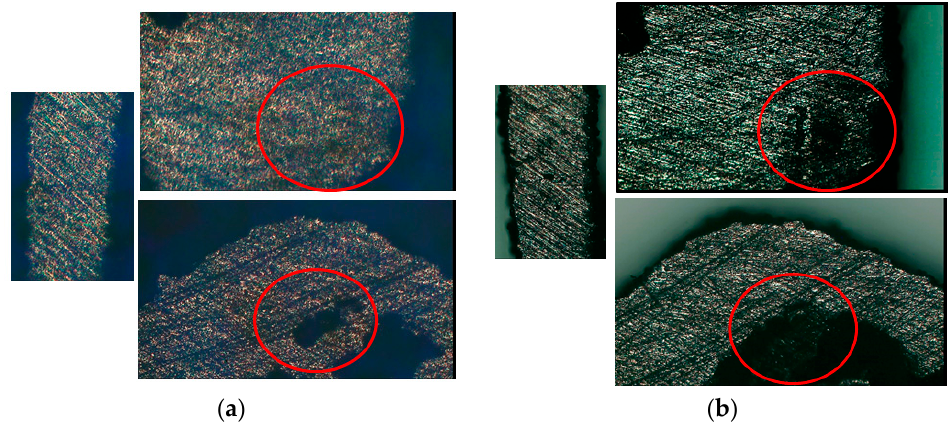
Figure 16. Specimens observed under the OM. ( a ) Before test; ( b ) after test.